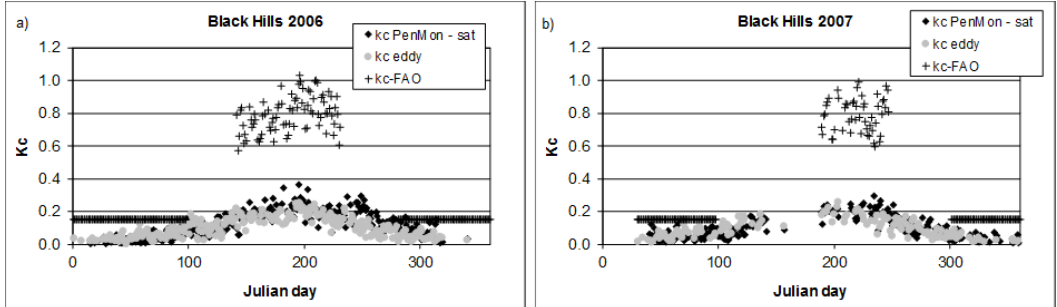
Figure 6. Crop coefficient values for Black Hills forest eddy covariance station for: ( a ) 2006; and ( b ) 2007.